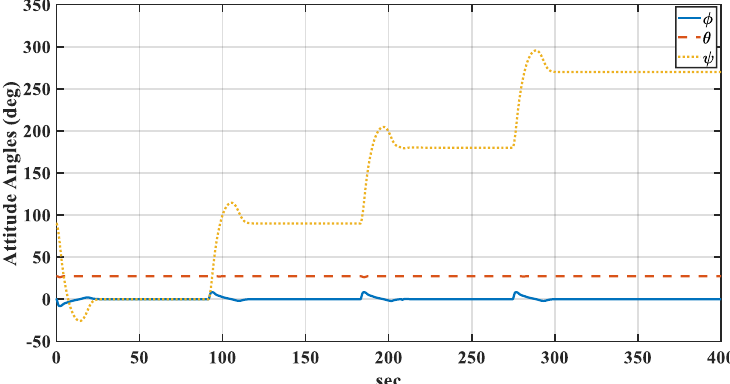
Figure 12. Attitude angles using the non-optimized FLC.